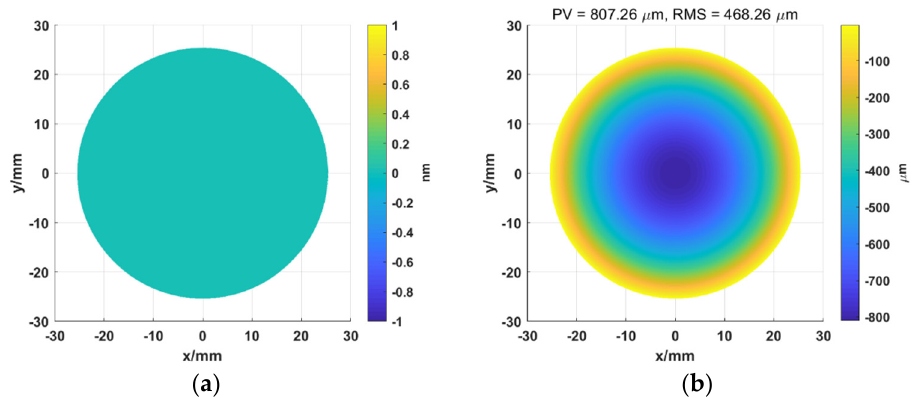
Figure 4. The simulation shape of specular objects. ( a ) The planar mirror model, a 50.8 mm cylinder with reflecting surface on the xOy plane of MCS. ( b ) The concave mirror model with 50.8 mm diameters, its focus f = 200 mm, the height of the edge is 8 mm, and its shape is a concave mirror.